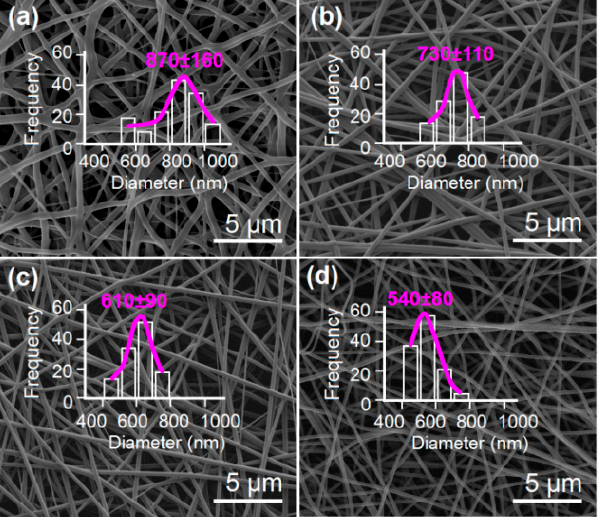
Figure 5. The scanning electron microscopy (SEM) images of the resultant nanofibers and their diameter distributions: ( a ) F1; ( b ) F2; ( c ) F3; ( d ) F4.